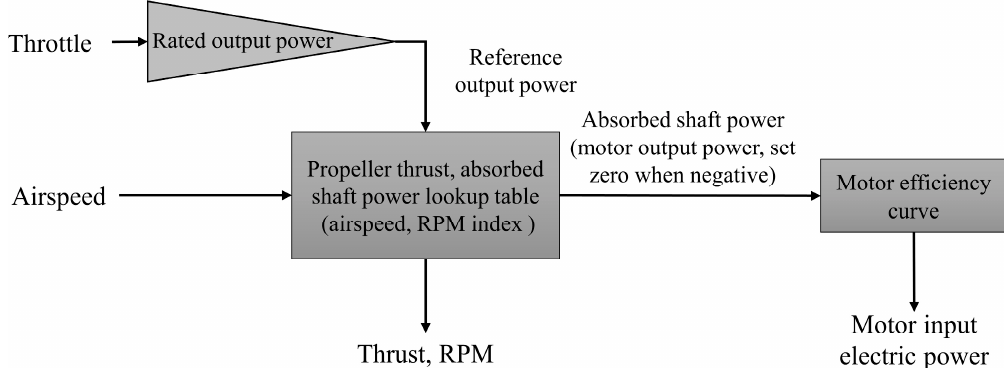
Figure 6. Data flow diagram for the propeller propulsion unit.